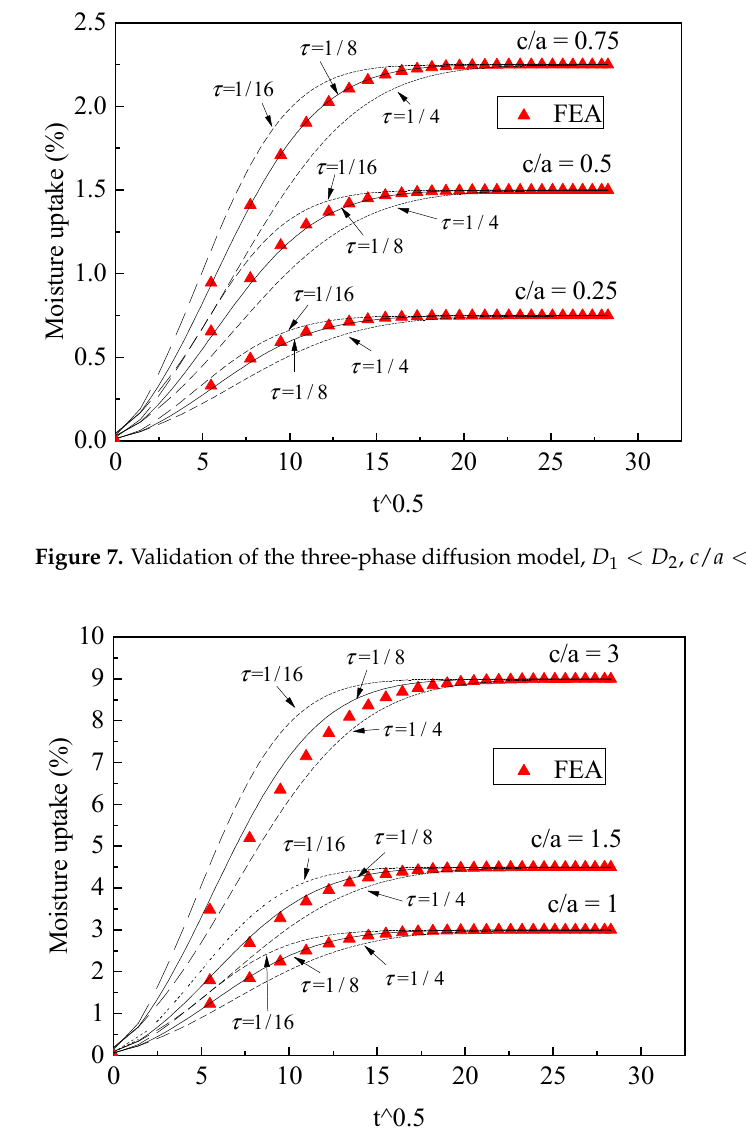
Figure 8. Validation of the three-phase diffusion model, D 1 < D 2 , c / a ≥ 1. If the fiber material is synthetic fiber, D 1 ( 0.02 ) > D 2 ( 0.005 ) . Comparisons